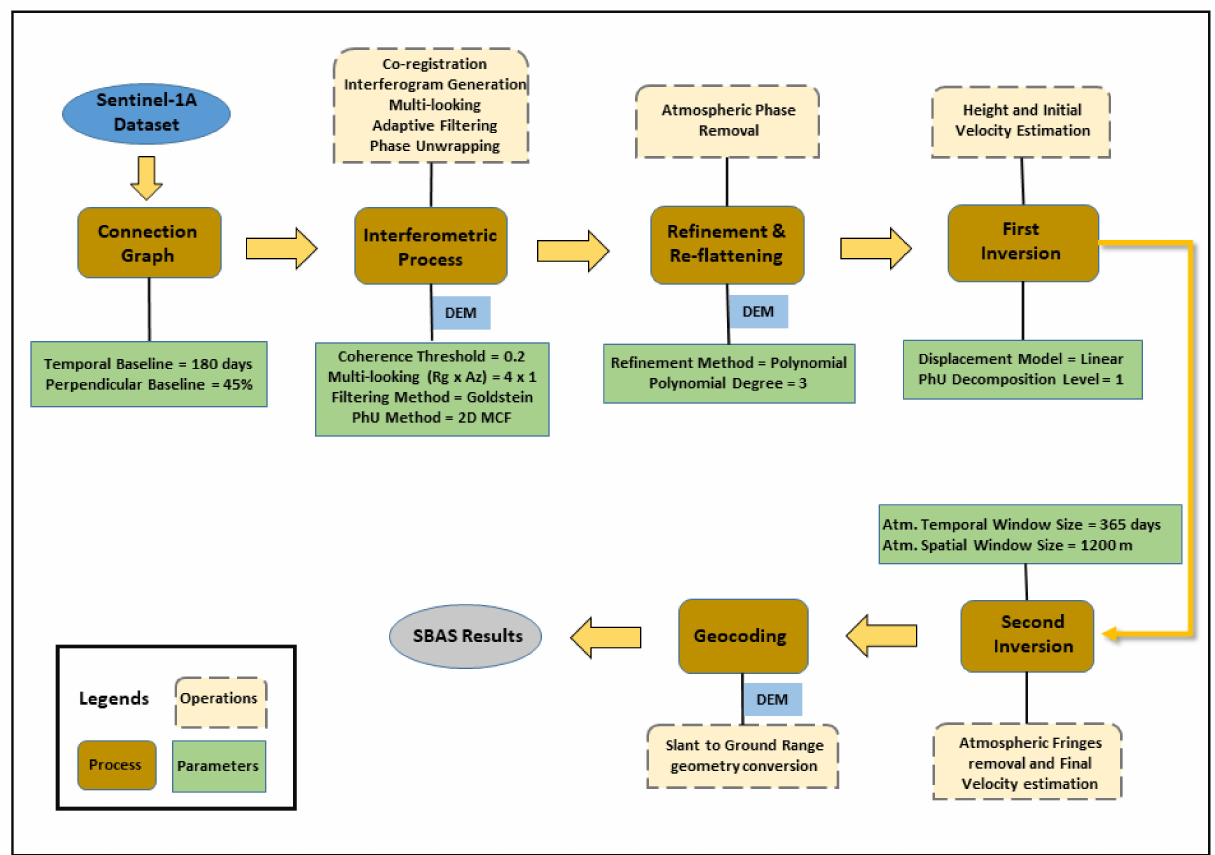
Figure 5. Interferometric Synthetic Aperture Radar processing workflow using small baseline subset